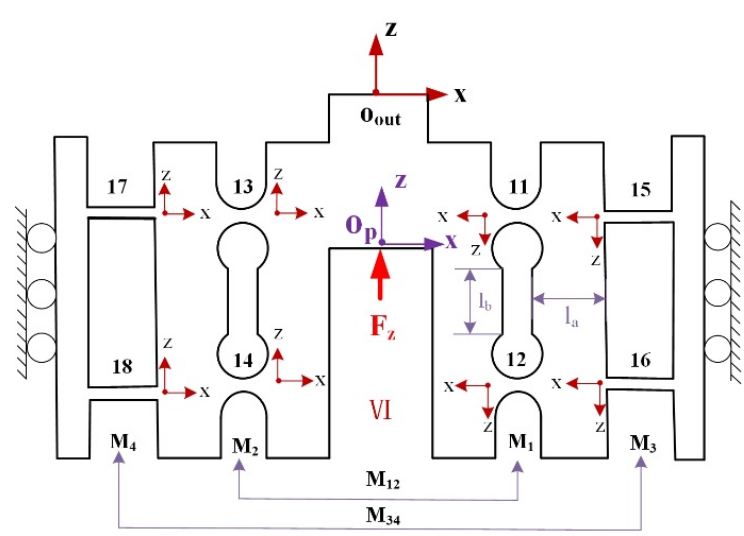
Figure 8. Schematic of the module VI.